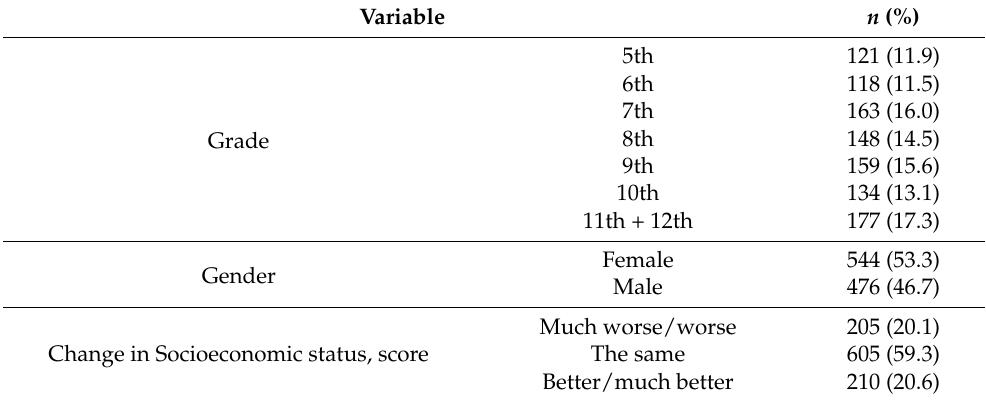
Table 1. Sociodemographic characteristics of study participants ( n =